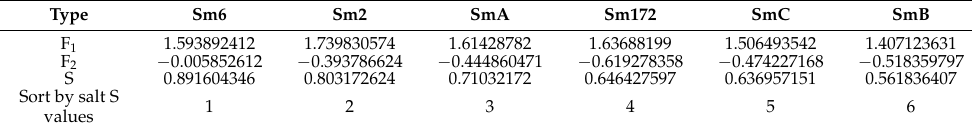
Table 6. Comparison of score calculated by principal components in six Salix matsudana